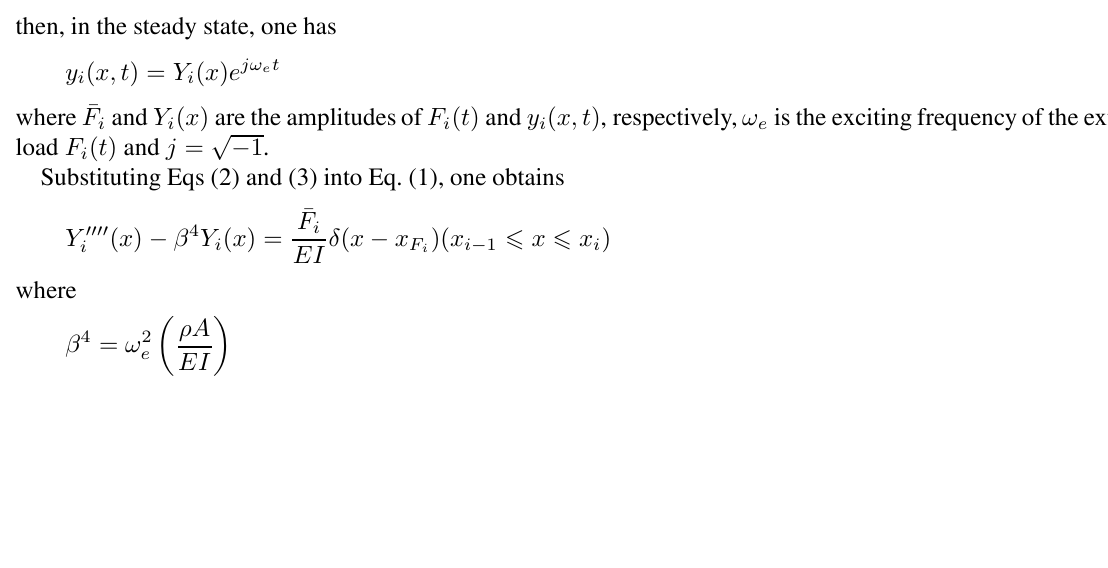
Fig. 7. The frequency-response curves for the three points p 1 , p 2 and p 3 on the beam (with “zero” initial conditions) shown in Fig. 6(a), located at: (a) ξ = x / L = 0.125, (b) ξ = x / L = 0.375 and (c) ξ = x / L = 0.5,